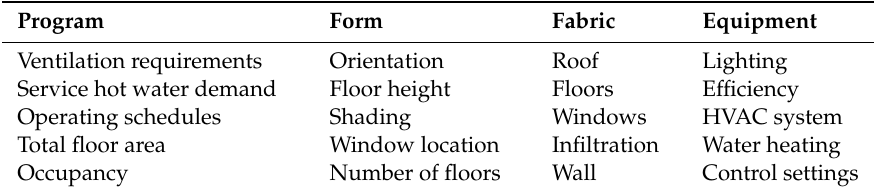
Table 1. The general model input information [48].